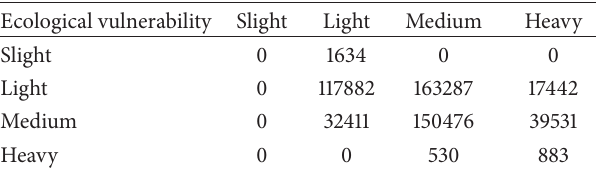
Table 4: Variation matrix of the ecological vulnerability between 1990 and 2005 (km 2 ).